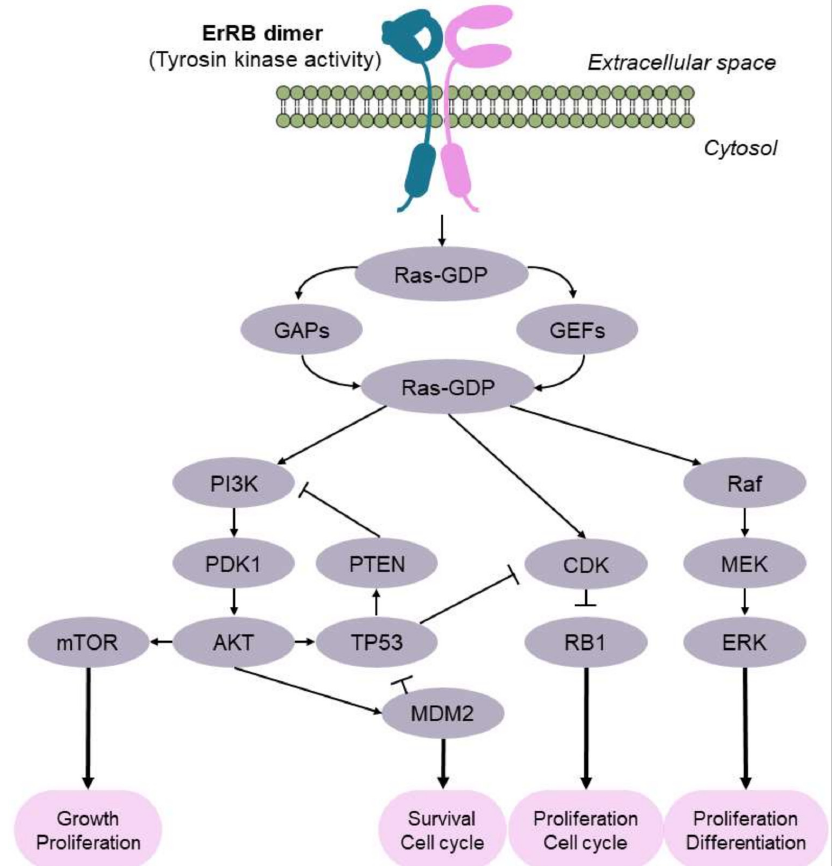
Figure 3. Schematic representation of the signaling pathways more commonly affected in bladder cancer. RAS signaling is associated with the ErRB dimer receptor, which is also a tyrosine kinase receptor frequently mutated in bladder